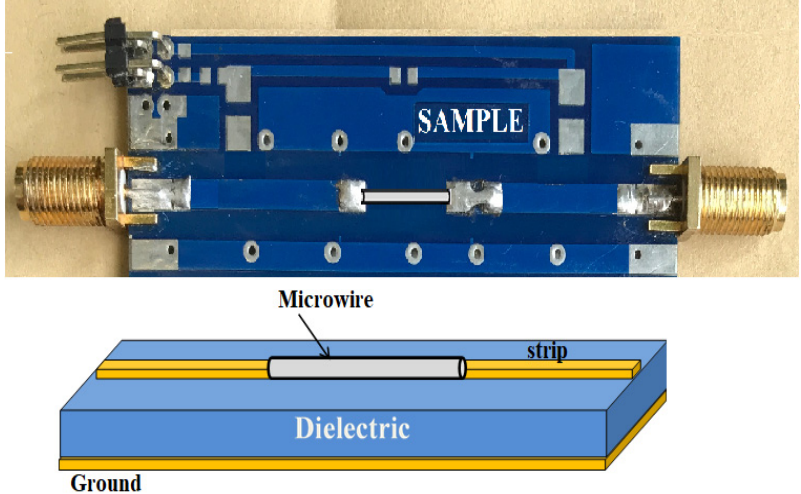
Figure 3. Wire sample as a planar waveguide resulting in a phase incursion: upper figure is a sample holder photo; bottom figure represents a schematic illustration.